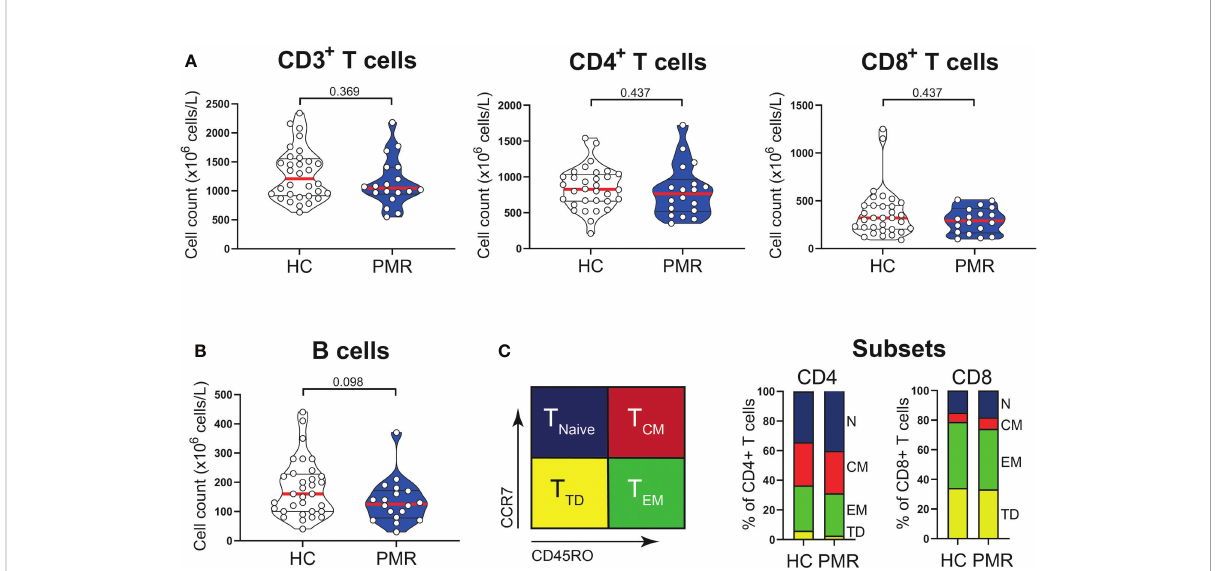
FIGURE 1 T cells in peripheral blood compartment of patients with PMR. (A) Absolute numbers of CD3 + T cells, CD4 + T cells, CD8 + T cells and (B) CD19 + B cells in peripheral blood of 18 patients with PMR and 32 healthy controls (HC). (C) Schematic overview (left panel) of fl ow cytometric gating for CD45RO - CCR7 + naive (T Naive ), CD45RO + CCR7 + central memory (T CM ), CD45RO + CCR7 - effector memory (T EM ) and CD45RO - CCR7 - terminally differentiated (T TD ) cells and percentages (right panel) of CD4 + and CD8 + T Naive , T CM , T EM and T TD cells in 18 patients with PMR and 32 healthy controls. Statistical signi fi cance by Mann-Whitney U test is